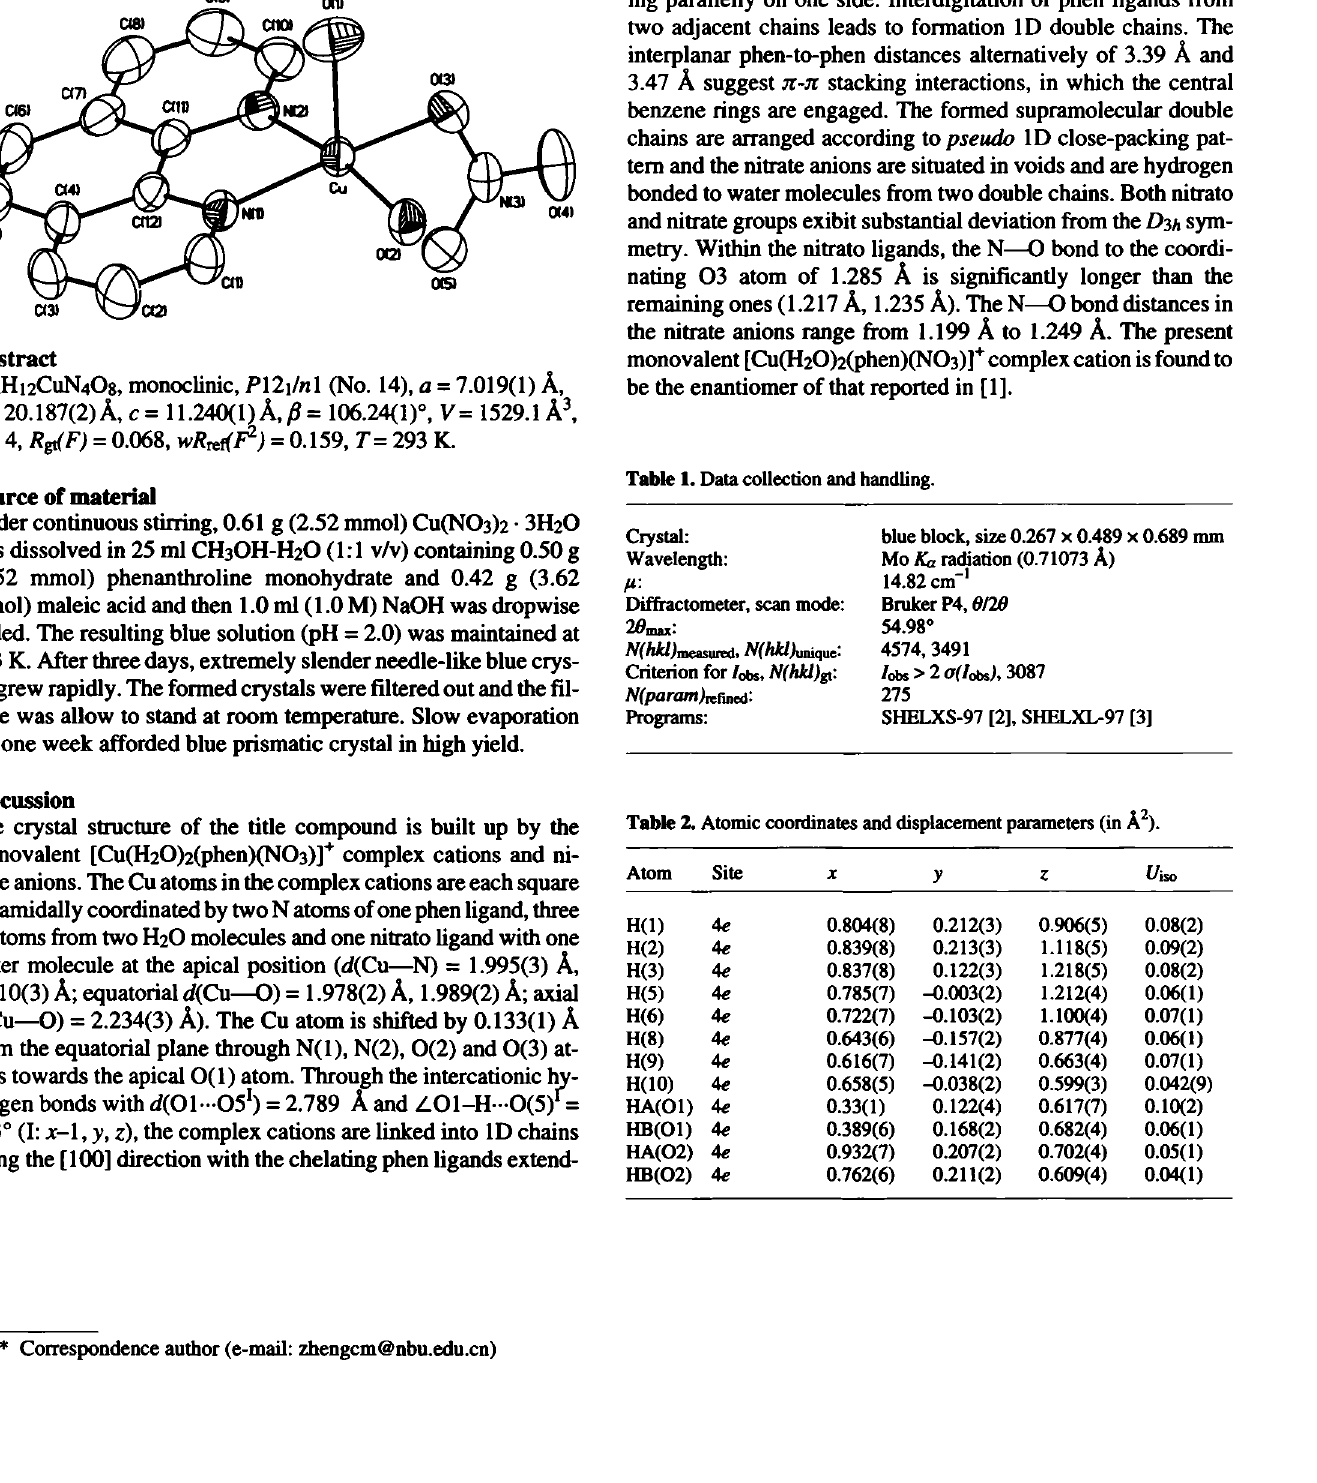
Table 1. Data collection and handling.